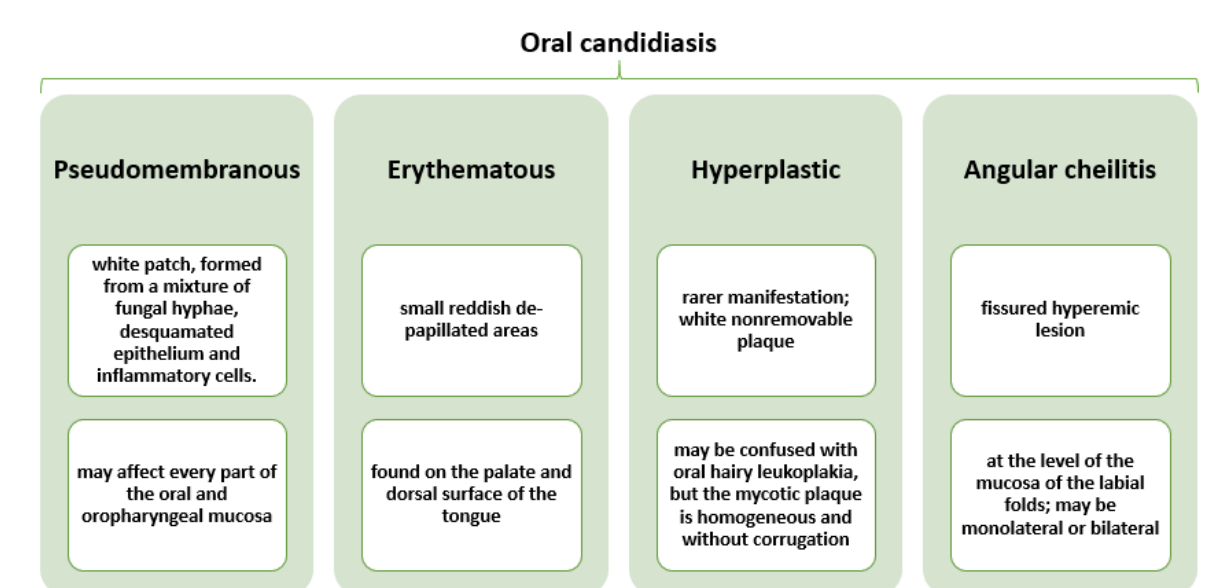
Figure 2. Characterization of different forms of oral candidiasis. Created based on information from reference [32].